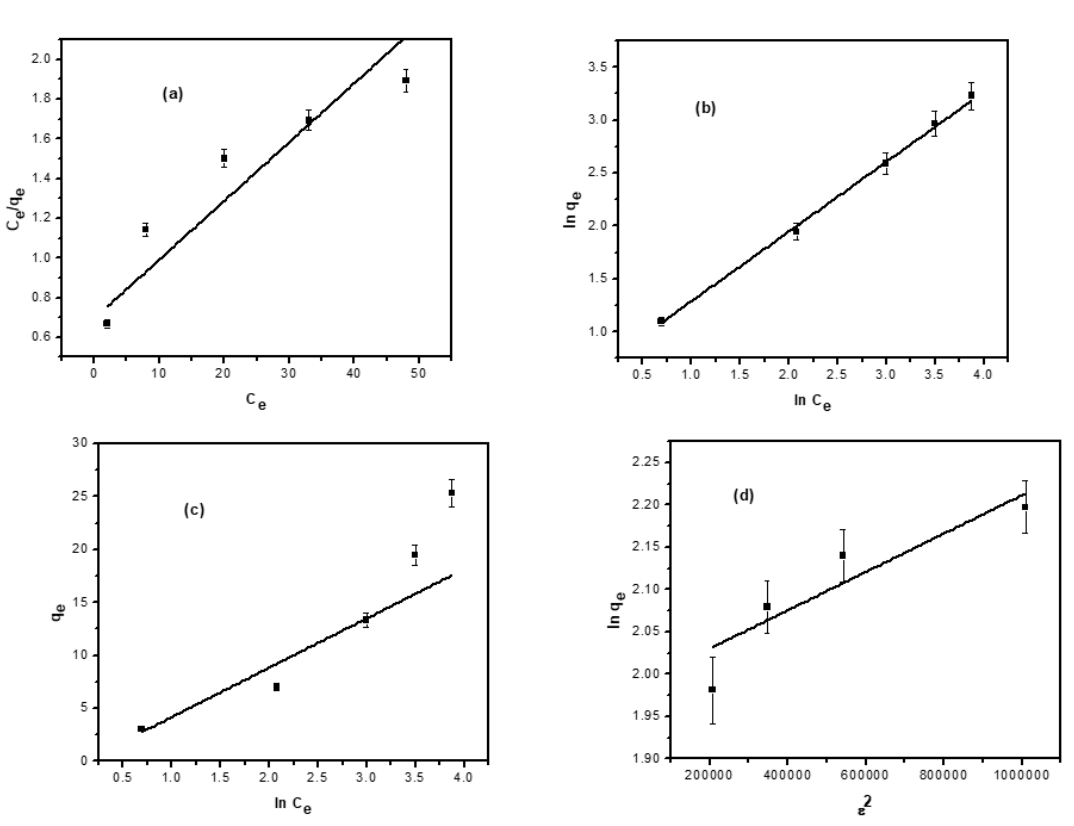
Figure 8. Isotherm models of adsorption of Ni(II) ions by the DSP ( a ), Langmuir, ( b ) Freundlich, ( c ) Temkin and ( d ) D-R.